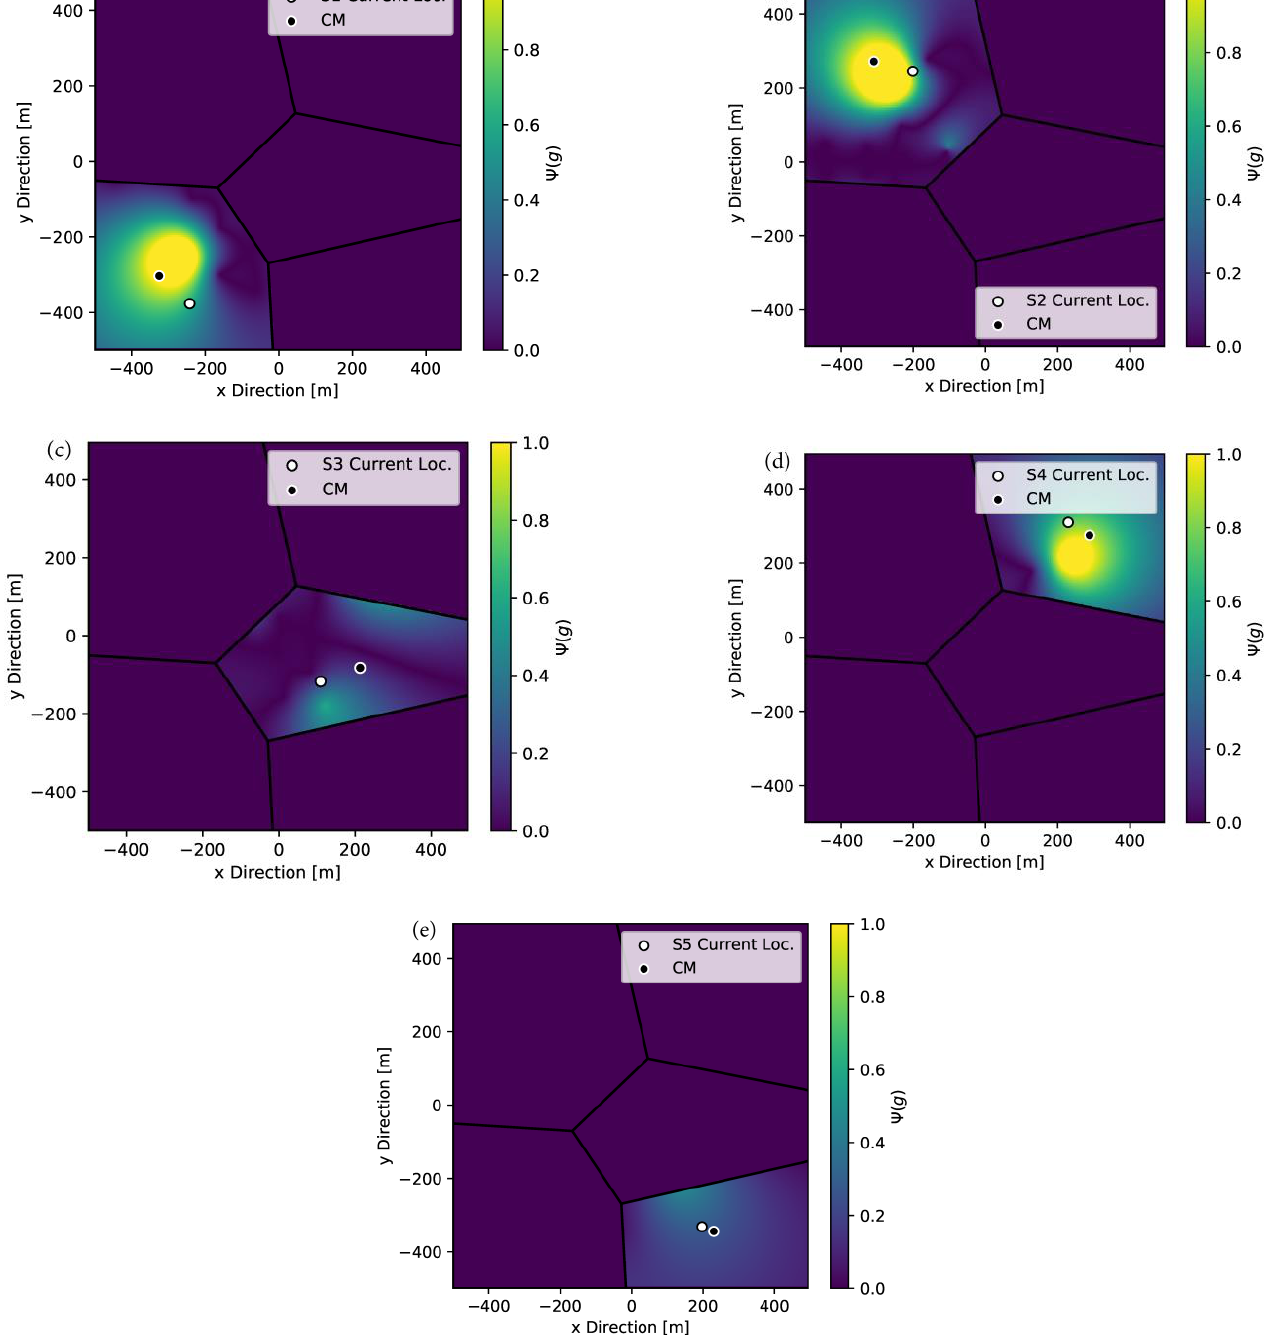
Figure 2. The PDM weighted Voronoi cells for a five-sensor survey showing the current sensor location and the calculated center of mass for ( a ) sensor 1, ( b ) sensor 2, ( c ) sensor 3, ( d ) sensor 4, and ( e ) sensor 5. The color bar represents the absolute fractional difference between successive predicted